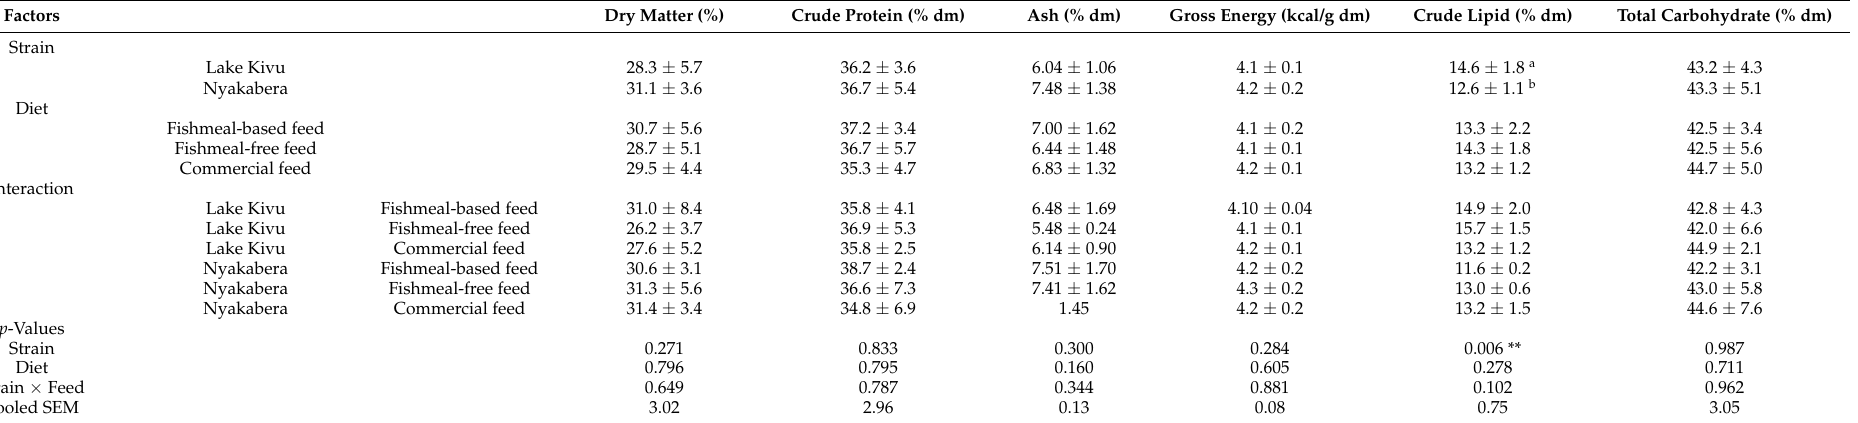
Table 4. Experiment 1 in Bukavu, eastern highlands DR Congo—mean ± standard deviation for whole body composition of Nile tilapia ( Oreochromis niloticus ) fry of the Lake Kivu and the Nyakabera strains fed on the commercial feed and the fishmeal-based and fishmeal-free feeds formulated using local ingredients †